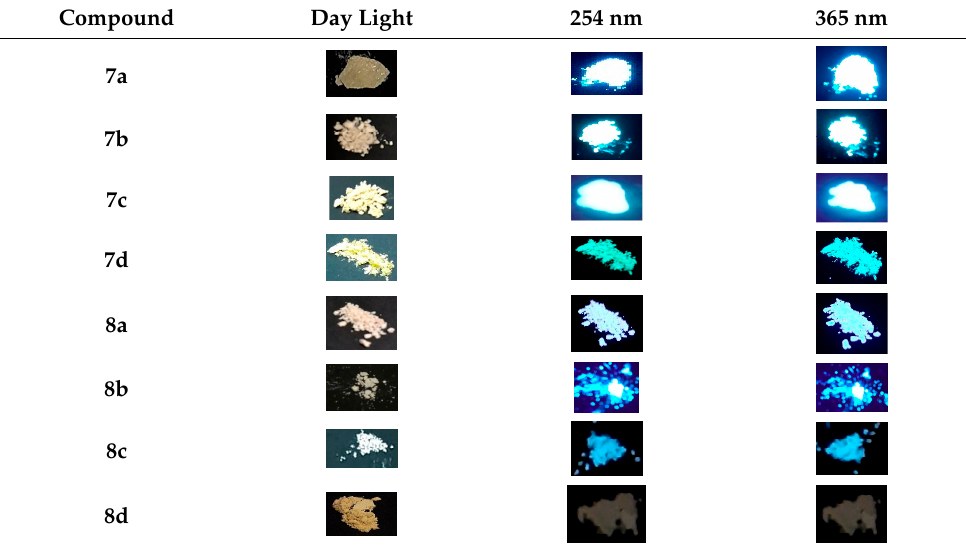
Table 2. Photographs of the ligands 7a – d and fluoroborates complexes 8a – d in solid state under UV lamp.